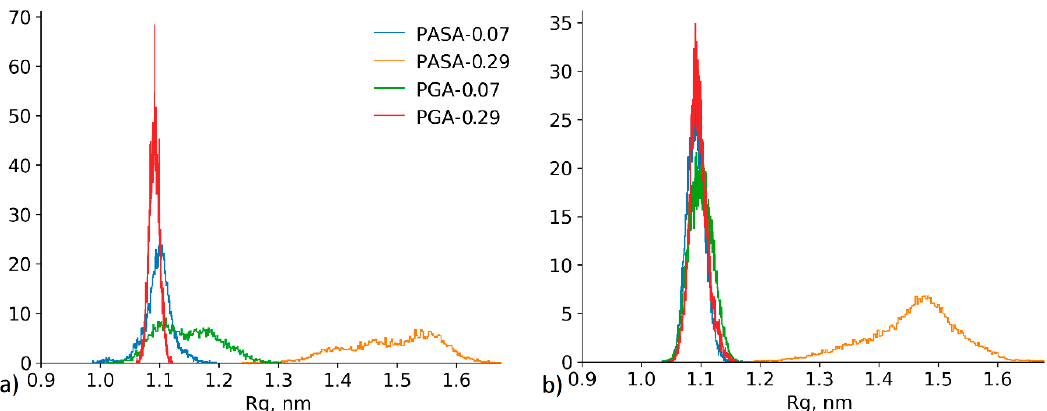
Figure 8. The radius of gyration distributions obtained from ( a ) HRE simulations and ( b ) classical non-biased MD simulation.